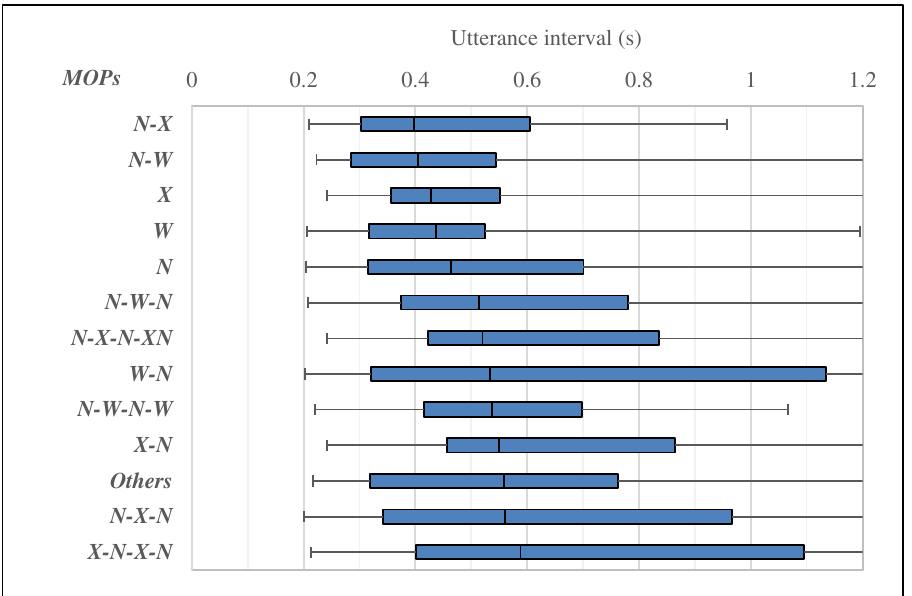
Figure 6. Box plot of utterance interval for each MOTP of current speaker during turn-keeping.